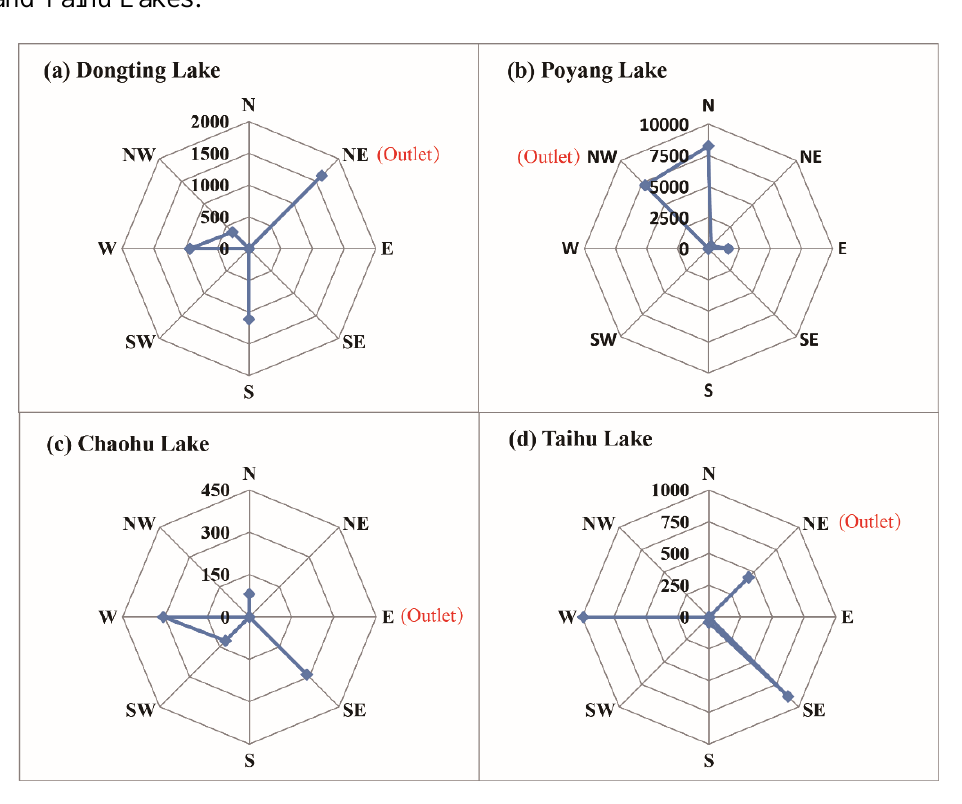
Figure 8. Rose diagrams of the movements of the centroids of the four lakes, ( a ) Dongting Lake; ( b ) Poyang Lake; ( c ) Chaohu Lake; ( d ) Taihu Lake. The units are in